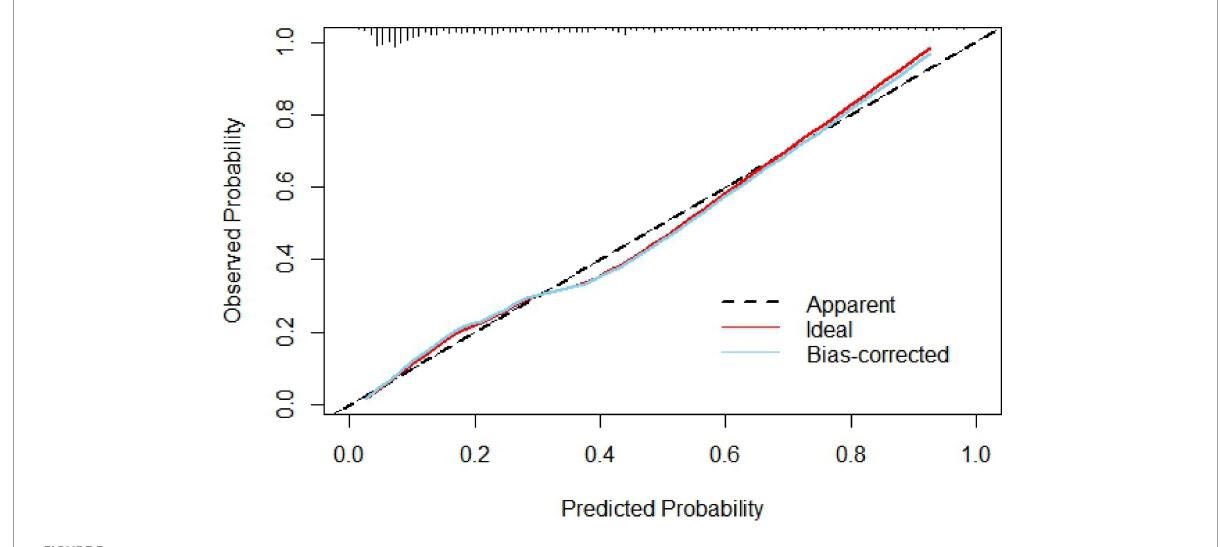
FIGURE3 Calibration curve.